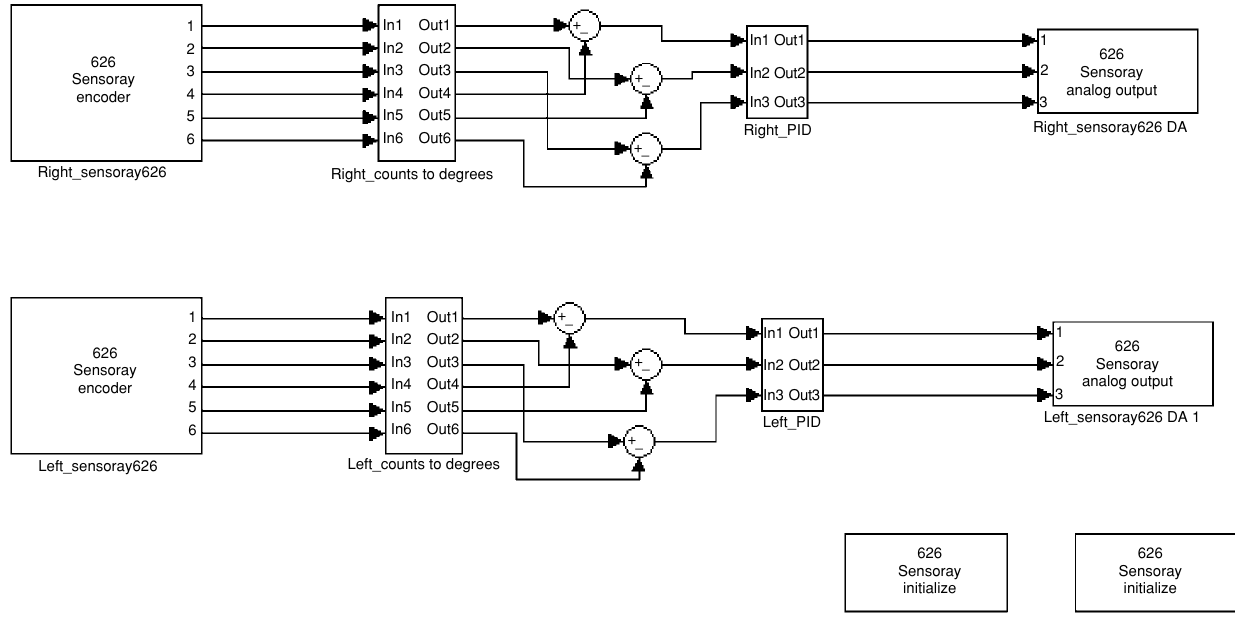
Figure 22 Hierarchical architecture for the control of biped locomotion (Vukobratovi´c et al. 1990).